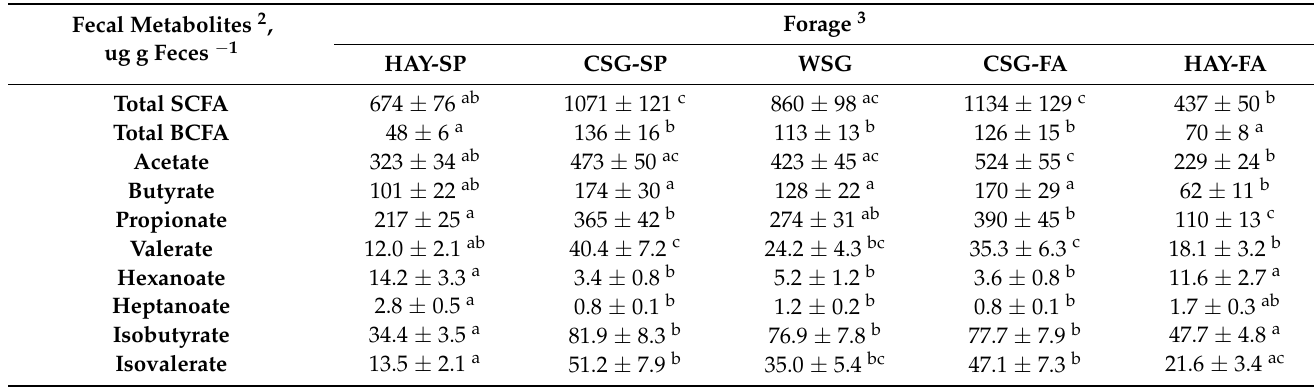
Figure 3. Fecal pH across forages within an integrated rotational grazing system including: HAY-SP: initial standardized cool-season grass hay diet in the spring; CSG-SP: cool-season grass pasture in the spring; WSG: warm-season grass, either crabgrass or bermudagrass, in the summer slump period; CSG-FA: cool-season pasture in the fall; HAY-FA: final standardized cool-season grass hay diet in the fall. Data are presented as least squares means ± SEM. A single asterisk indicates differences between forages at p ≤ 0.05 (mixed model ANOVA with Tukey’s post hoc adjustment). Table 6. Fecal metabolite concentration 1 of horses adapted to hay diets and pasture